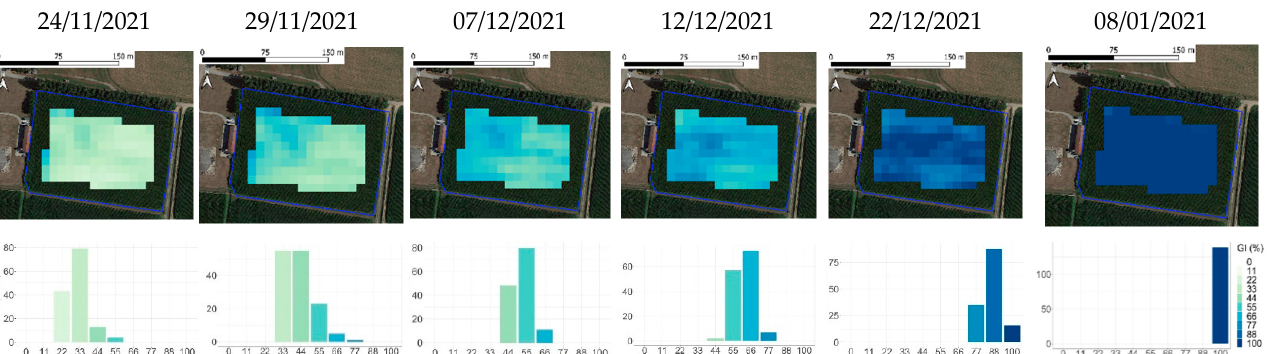
Figure 8. Maps of the frost damage index of a white mustard cover crop (GI, ranging from 0% = no damage, to 100% = complete crop destruction) estimated from MMSR for each satellite image available for the field in Ghedi during the monitoring campaign.